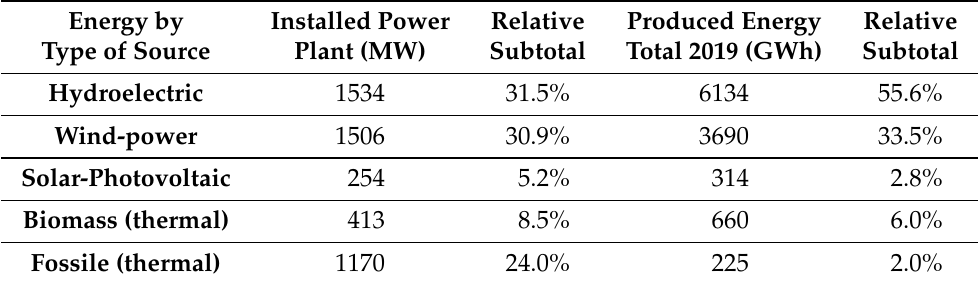
Table 1. Details of the installed power plant and energy by type of source [ADME: 2019, UTE: 2019]. Energy